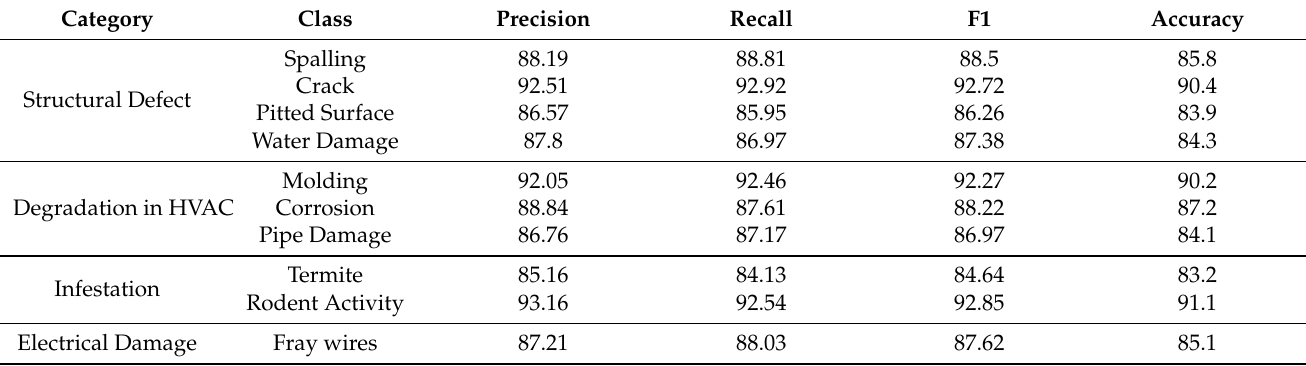
Table 7. Statistical measures for the deterioration detection framework (Faster Inception